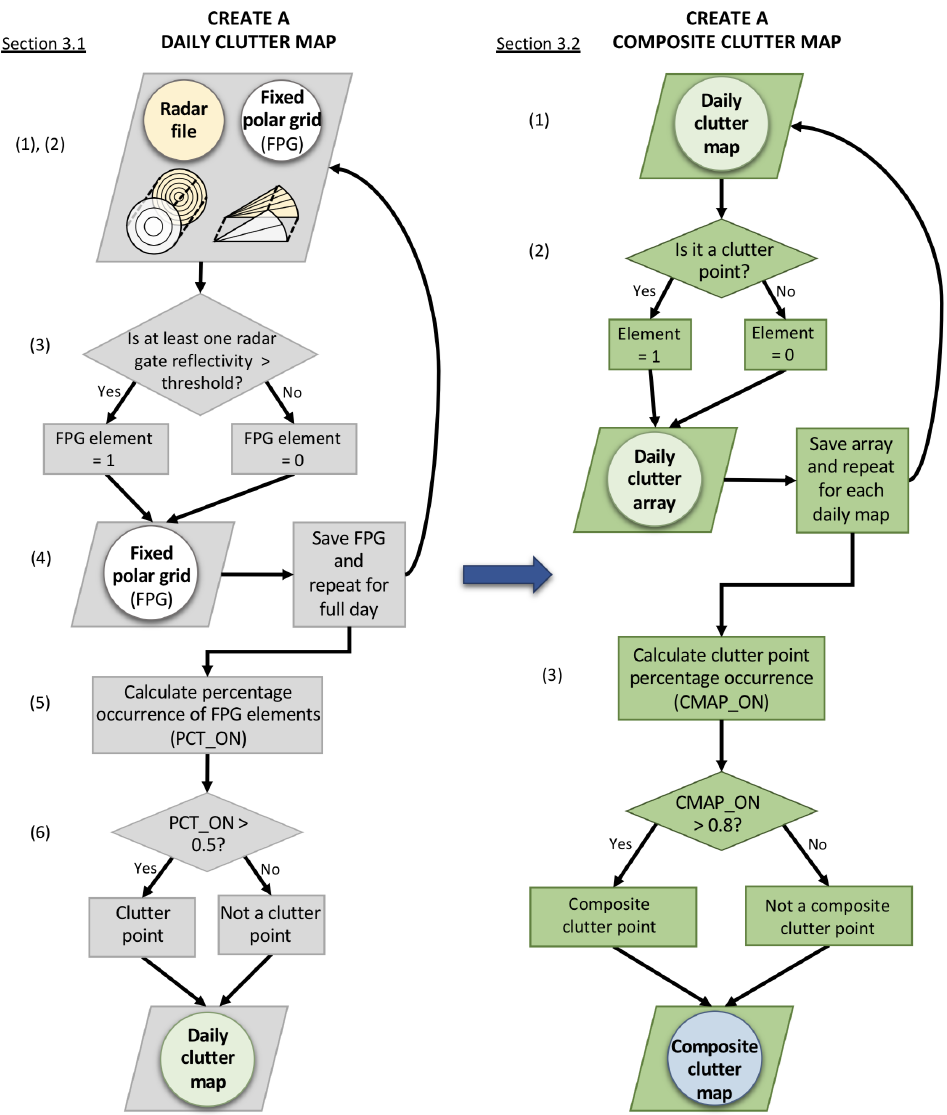
Figure 4. Workflow for designing the clutter map used to calculate the baseline value. The first chart shows how a clutter map is created from a single day of data. The second chart shows how multiple daily maps can be combined into a composite map used in this work that is more resistent to temporal